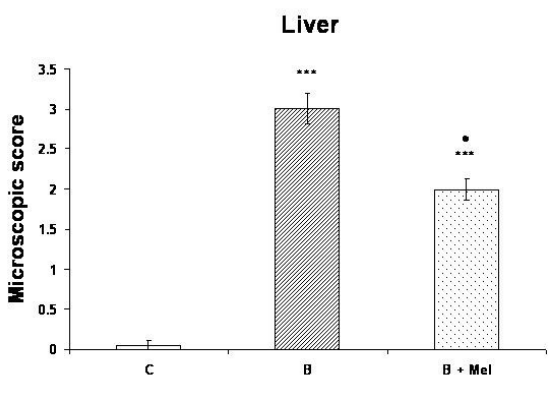
Figure 2. Microscopic damage scores of liver. (C) - vehicle treated rats without burns; (B) -vehicle treated rats with burns; (B+Mel) - melatonin treated rats with burns *** p<0.001 vs to control group; •p<0.05 vs vehicle treated rats with